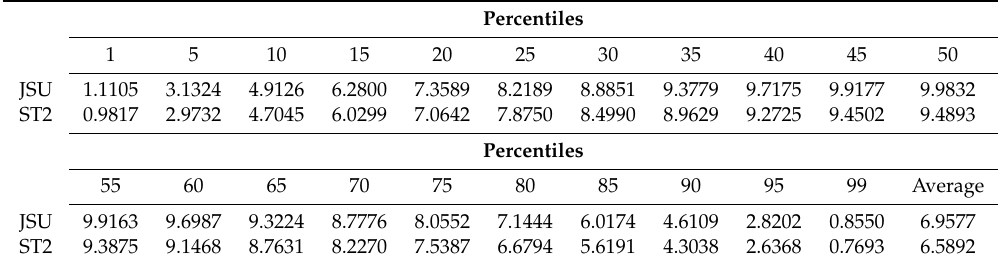
Table 3. Pinball scores for tested